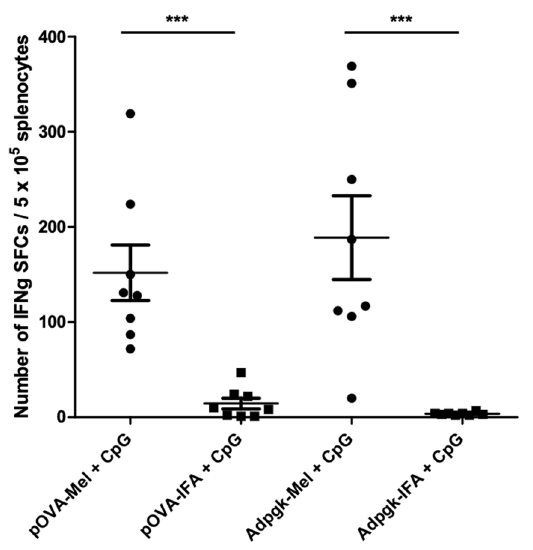
Figure 4. A vaccine formulation based on L-DOPA melanin triggers robust T cell responses against short and long peptides. ELISpot analysis of splenocytes on day 21 after subcutaneous immunizations on days 0 and 14 of C57/Bl6 mice with the indicated formulation containing the long peptide pOVA (SMLVLLPKKVSGLKQLESIINFEKLTKWTS) or the short peptide mAdpgk (KKASMTNMELM). CpG: 5 ′ -TAAACGTTATAACGTTATGACGTCAT (Oligovax, Paris, France); IFA: incomplete Freund’s adjuvant (Sigma-Aldrich, Saint-Quentin-Fallavier, France). IFNg: interferon gamma; SFC: spot-forming cell. Each point represents an individual mouse ( n = 8 mice/group with pooled data from 2 different experiments). Bars: mean values ± standard error of the mean (SEM). *** p < 0.001. For more detail on methods, see Cuzzubbo et al. 2020 [57].